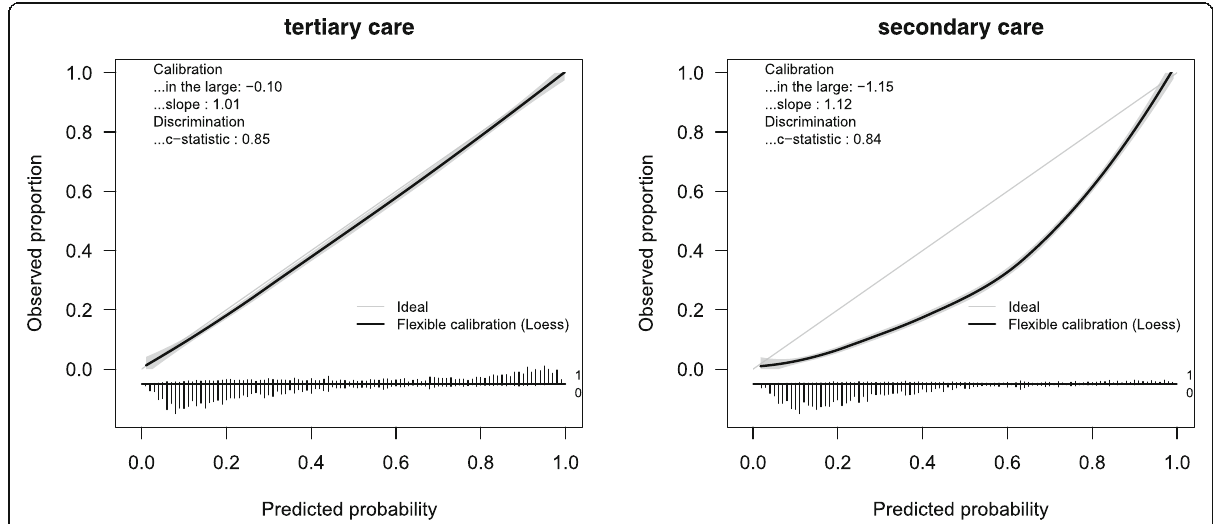
Fig. 6 Example of a prediction model built in tertiary care that is generalizable to a new tertiary care center but not transportable to a new secondary care